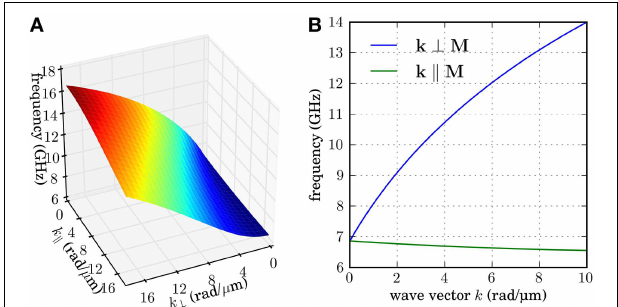
FIGURE 1 | (A) Two-dimensional, anisotropic dispersion surface for an in-plane magnetized magnetic thin film depending on the wave-vector components parallel k k and perpendicular k ⊥ to the static magnetization based on the analytical model by Kalinikos and Slavin [53]. (B) The comparison of the dispersion lines for k k and k ⊥ puts emphasis on the different character of the corresponding spin-wave modes. In particular, the group velocities defined by the slope of the dispersion lines and, thus, the spatial decay of these two spin-wave modes strongly differ leading to a preferred propagation direction with k ⊥